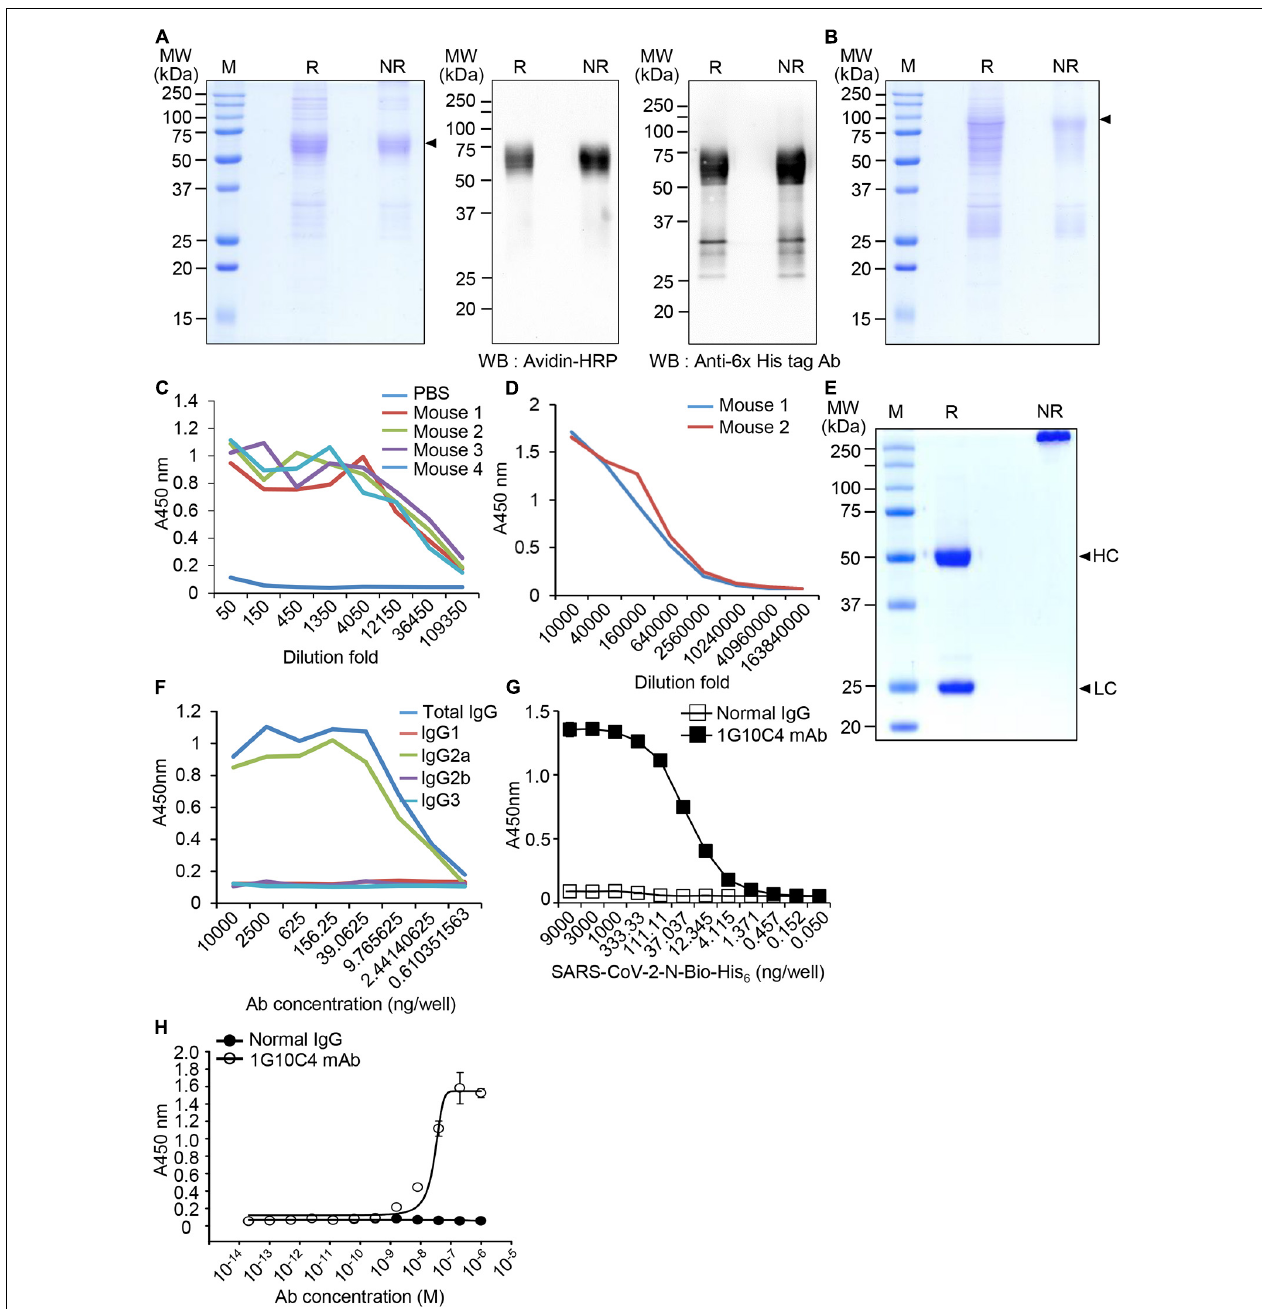
FIGURE 1 | Production and characterization of the anti-SARS-CoV-2 N protein-specific monoclonal antibody. (A) Expression of biotin peptide-6 × His-tagged SARS-CoV-2 N protein (SARS-CoV-2 N-Bio-His 6 ). Recombinant SARS-CoV-2 N-Bio-His 6 protein was expressed in ExpiCHO cells and purified from cell culture supernatants using Ni-NTA agarose chromatography. The purified recombinant protein was analyzed by SDS-PAGE (left) and western blotting with peroxidase-conjugated streptavidin (middle) and anti-His-tag antibody (right). Arrowhead, biotin peptide-6 × His-tagged SARS-CoV-2 N protein; R, reducing condition; NR, non-reducing condition. (B) Expression of biotin peptide-6 × His-tagged MERS-CoV N protein (MERS-CoV N-Bio-His 6 ). The purified recombinant protein was analyzed by SDS-PAGE. Arrowhead, biotin peptide-6 × His-tagged MERS-CoV N protein. (C) The recombinant SARS-CoV-2 N-Bio-His 6 protein and CpG-DNA were combined in a DOPE:CHEMS complex and the complex was injected intraperitoneally into BALB/c mice ( n = 4) three times. ELISA was performed with mouse sera to determine whether recombinant SARS-CoV-2 N-Bio-His 6 protein-specific antibody was present. (D) Ascites were collected from mice injected with cloned hybridoma cells (1G10C4). ELISA was performed with the ascites to determine whether recombinant SARS-CoV-2 N-Bio-His 6 protein-specific antibody was present. (E) The monoclonal antibody was purified from the ascitic fluid using Protein-A column chromatography and analyzed using SDS-PAGE. HC, heavy chain; LC, light chain. (F) Subclasses of the monoclonal antibody were identified by ELISA. (G) The detection limit of the monoclonal antibody against SARS-CoV-2 N-Bio-His 6 protein was measured by ELISA. (H) Binding of the monoclonal antibody to recombinant SARS-CoV-2 N-Bio-His 6 protein was measured by ELISA.